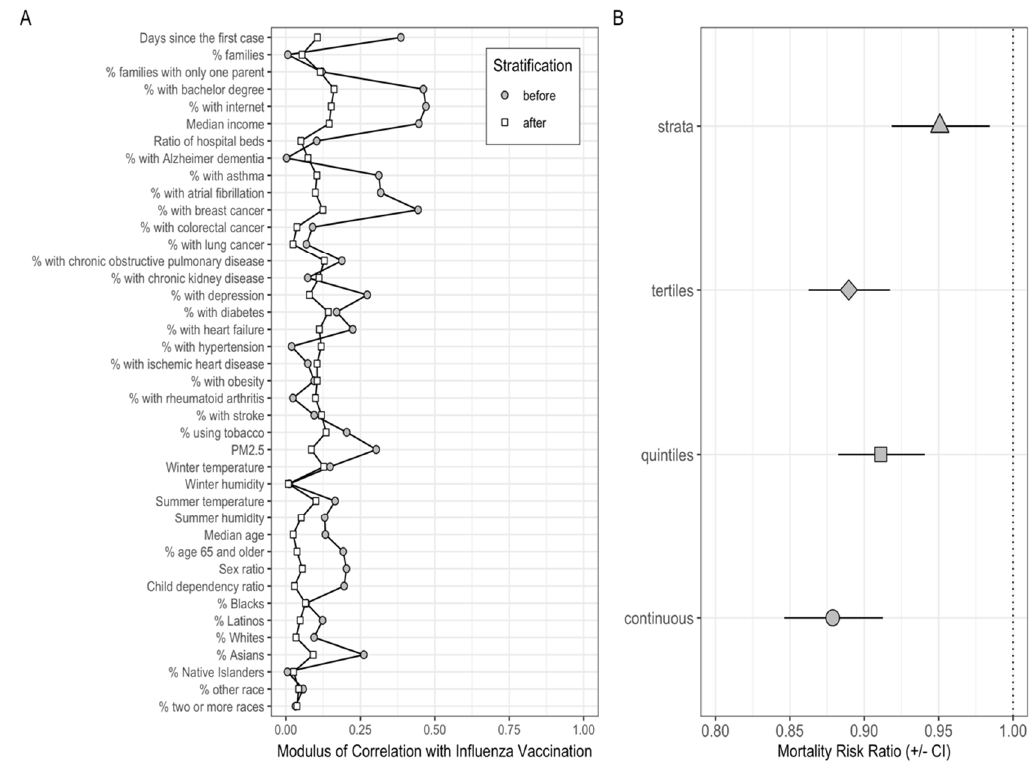
Figure 3. Effect of influenza vaccination coverage in the elderly on COVID-19 mortality after adjusting for the potential confounding variables. ( A ) Absolute correlation between potential confounders and influenza vaccination before (grey circles) and after (white squares) propensity-score (PS) stratification. ( B ) Mortality-rate ratio (MRR) of COVID-19 associated with a 10% increase in influenza vaccination coverage using different PS regression methods to adjust for confounding variables. Each symbol represents different PS regression methods: (a) strata: data divided into three strata on the basis of the estimated PS. In each stratum, we fit a quasi-Poisson regression model using the number of COVID-19 deaths as the outcome and influenza vaccination coverage in the elderly as the exposure variable, adjusting for the PS and using the total county population as offset; (b) tertiles: we divided the PS into tertiles and included it as a factor in the main model; (c) quintiles: same with quintiles; and (d) continuous: we used the PS as a continuous term in the outcome model. In all models, we also adjusted for US states. For stratified analyses, the MRR shown is the inverse-variance weighted MRR across the three strata.